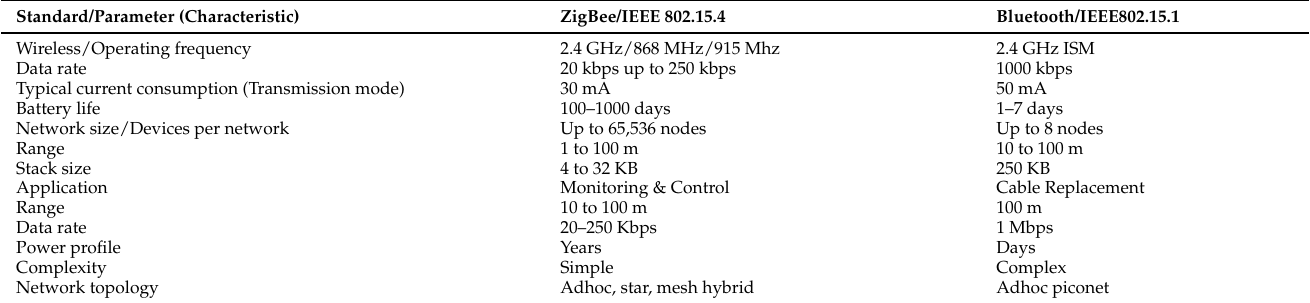
Table 6. Key Features of Bluetooth and ZigBee Wireless Technologies